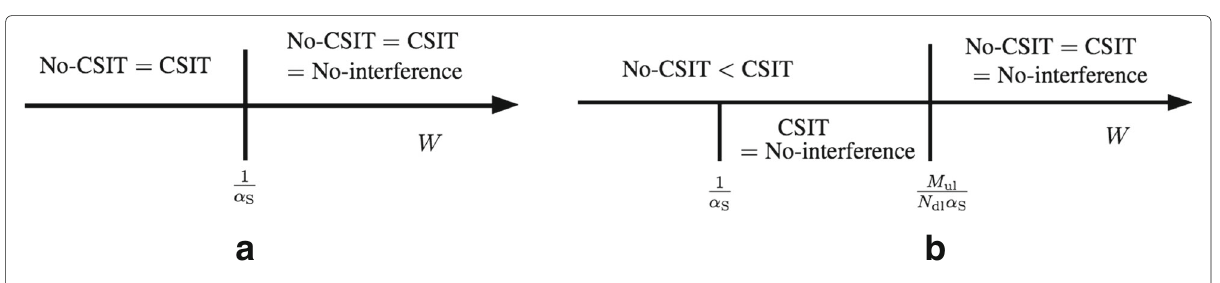
Fig. 9 Comparison of the three systems in DoF as a function of the side-channel bandwidth when α I = 1. a N dl ≥ M ul , b M ul > N